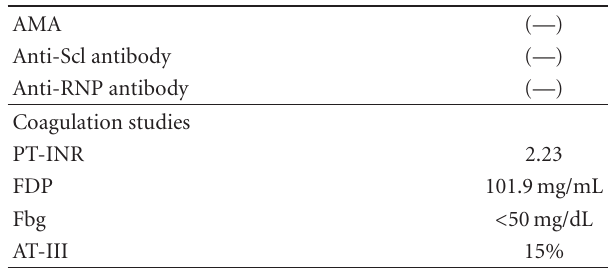
Table 1: Laboratory data on